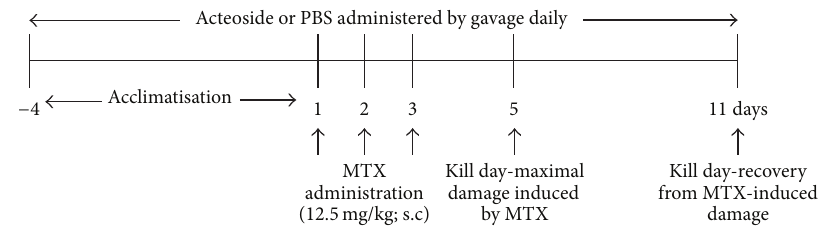
Figure 1: Schematic diagram of the experimental